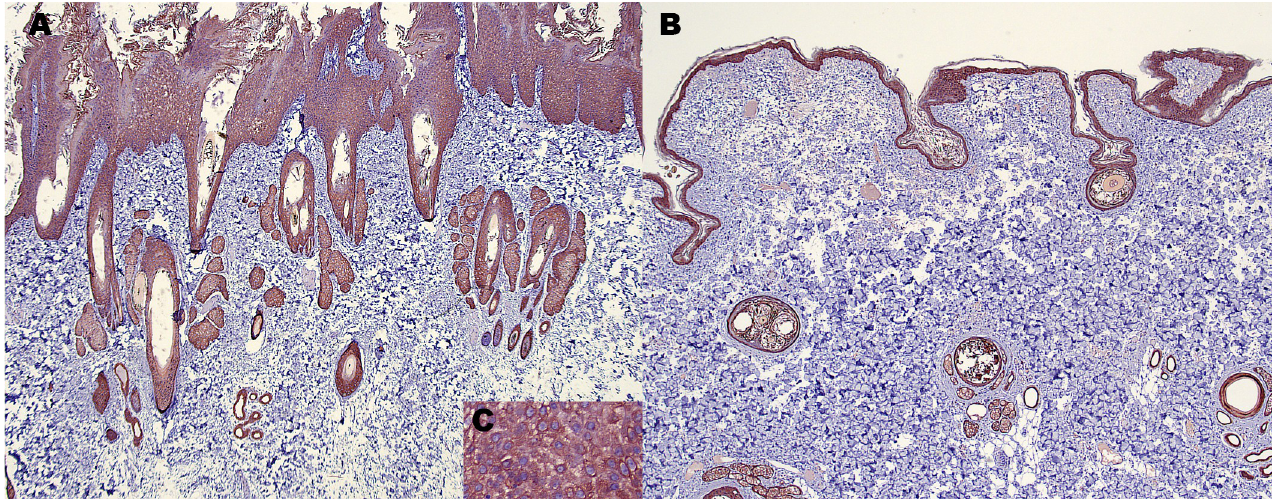
Fig 4. KRT1 expression in Chinese shar-pei skin (immunohistochemistry with anti-KRT1 antibody). (A) Intensity of KRT1 expression in the epidermis and follicular epithelia of the affected Chinese shar-pei is comparable to (B) normal Chinese shar-pei skin (40x). (C) Strong KRT1 expression in the epidermis of the affected Chinese shar-pei